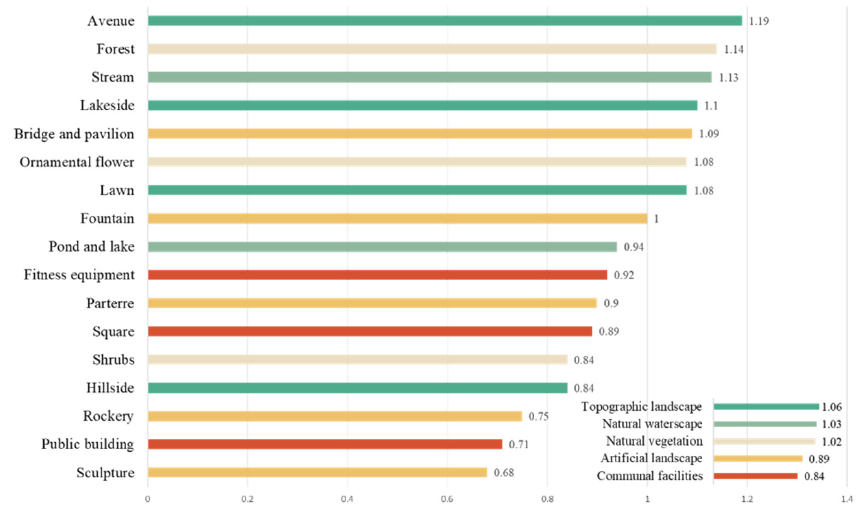
Figure 5. Average landscape preferences of exercisers in urban forest park.